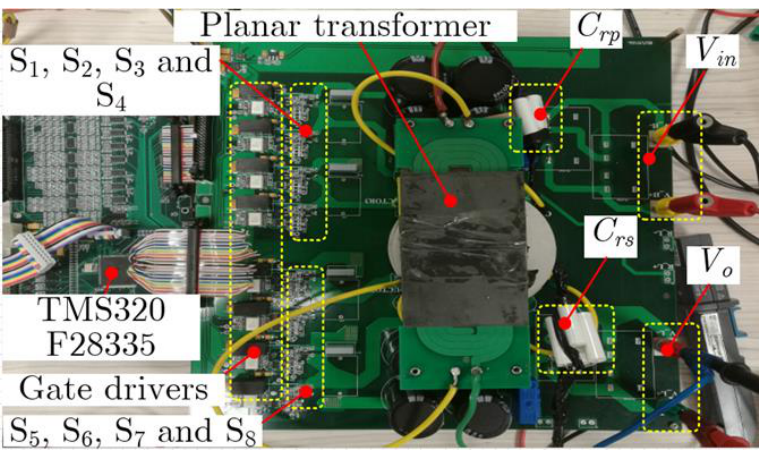
Figure 15. The CLLC resonant converter for the validation.